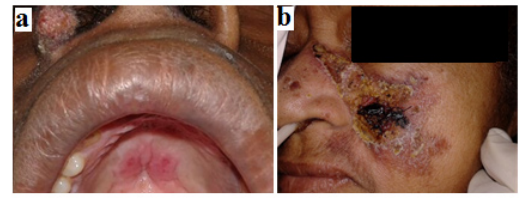
Figure 3. Ulcerated oral lesions in hard palate reported at Case-5 ( a ). Leishmaniasis lesion in the left malar region reported at Case-6 ( b